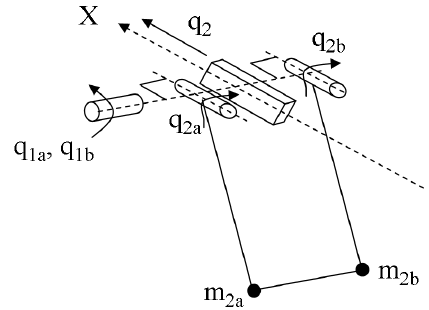
Figure 10: Definitions of the variables at the actuator side for the double link.